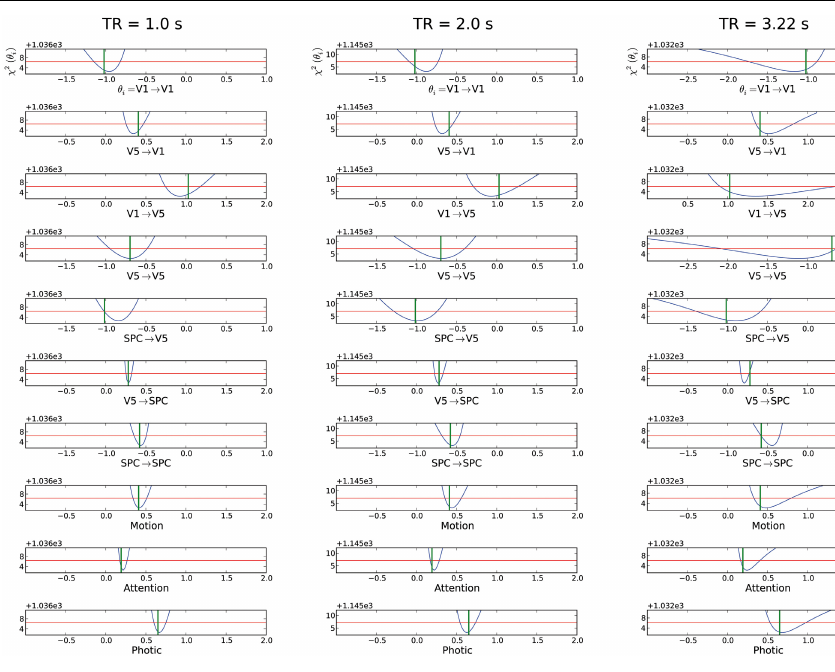
FIGURE 2 | Assessment of different TRs (1, 2, the original 3.22 and 6.44s) for the “forward model.” The parameter value used for the simulation is shown as a green vertical line. The blue line corresponds to the profile likelihood. The red horizontal line illustrates the χ 2 -quantile to a significance level of 1 − α with α = 5%. The parameter is identifiable if the blue line crosses the red line twice, i.e., if boundaries on confidence intervals exist. The respective connection is described below the individual profile likelihood plot with the respective